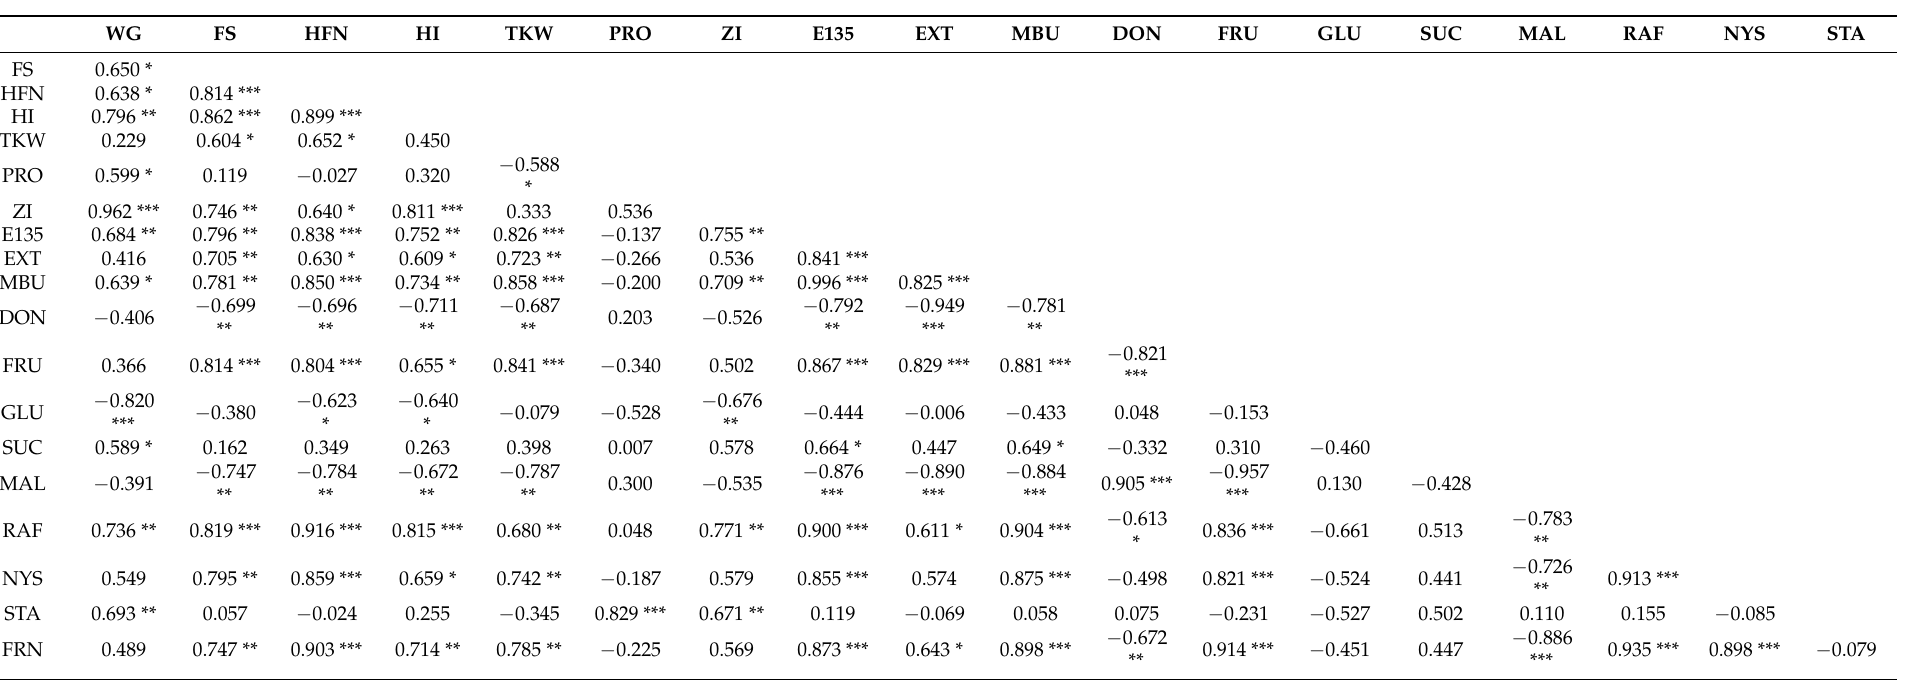
Table A2. Pearson’s correlations between simple carbohydrate content, wheat quality parameters and DON toxin after responses of fungicide treatments,